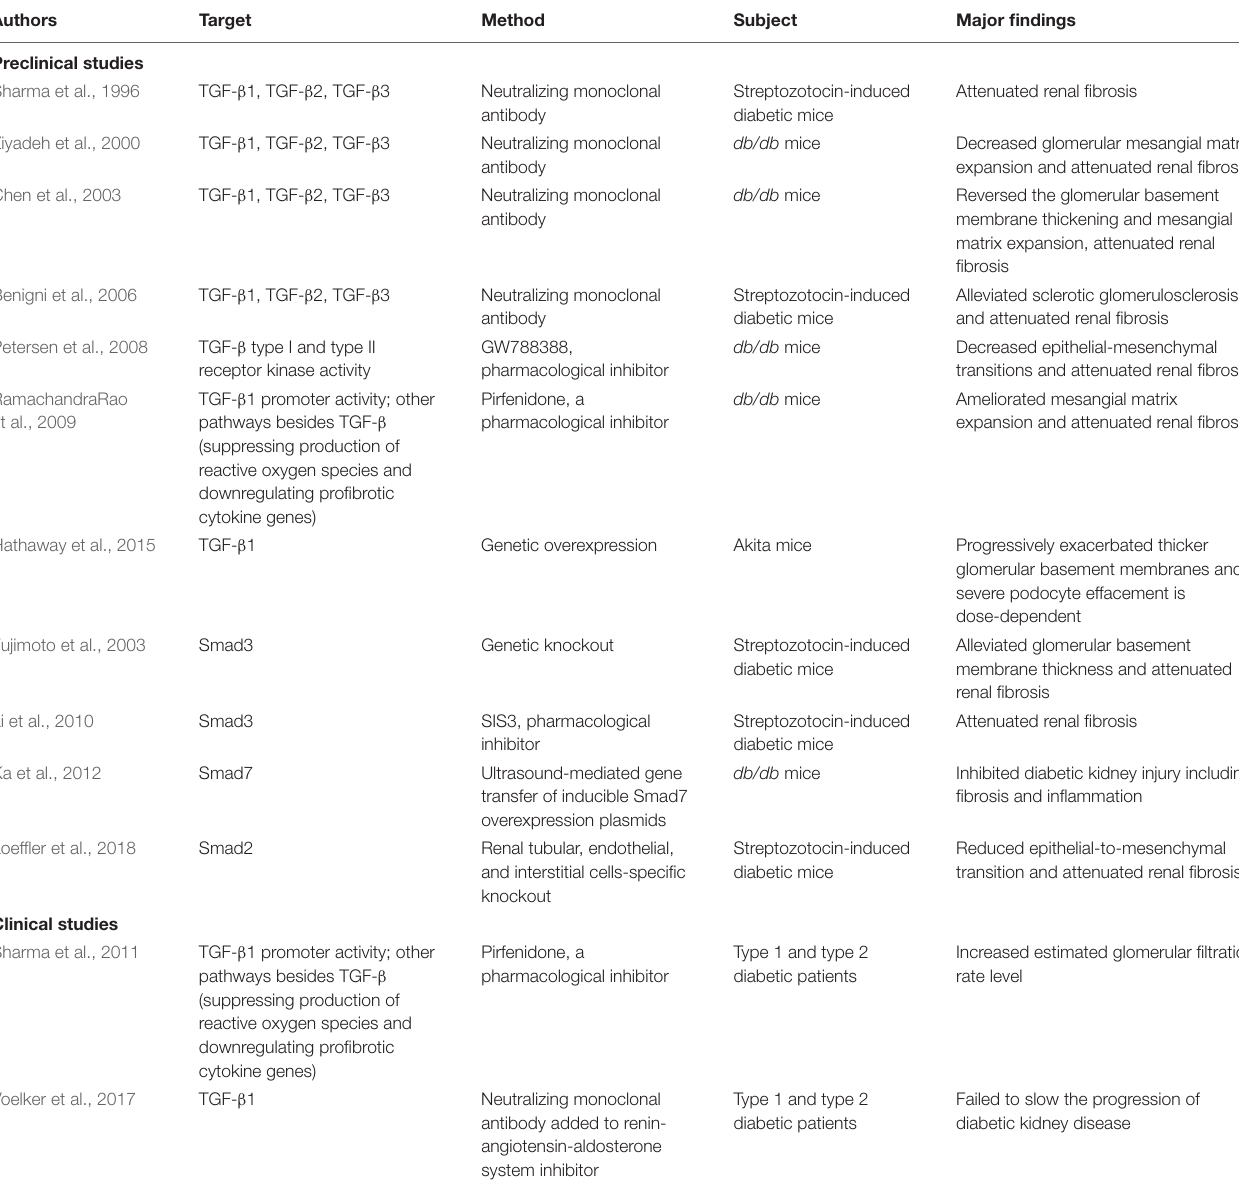
TABLE 1 | Pre-clinical and clinical studies aimed to TGF- β signaling in diabetic kidney disease.